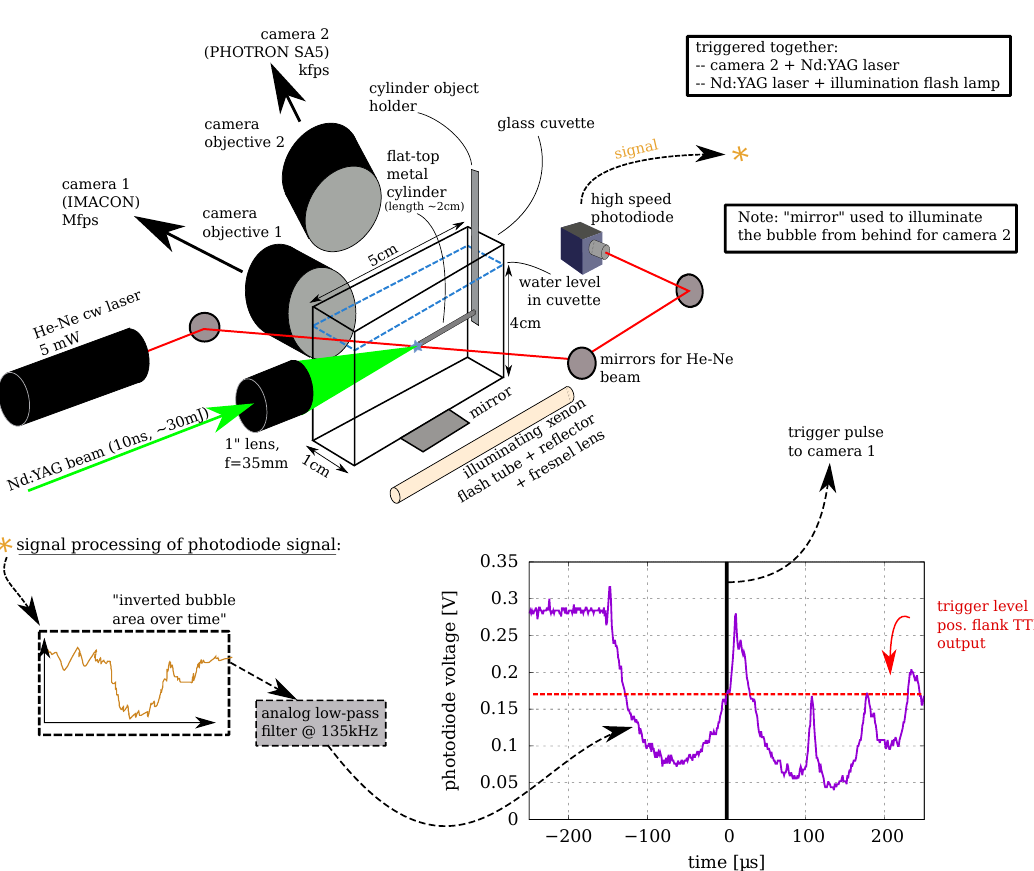
Figure 2. Sketch of the experimental arrangement. The He-Ne laser allows for triggering onto bubble dynamics phases with approximately 1µs precision. A typical bubble “shadow” curve with trigger level is shown in the lower right inset. The xenon flash tube refers to the Mecablitz